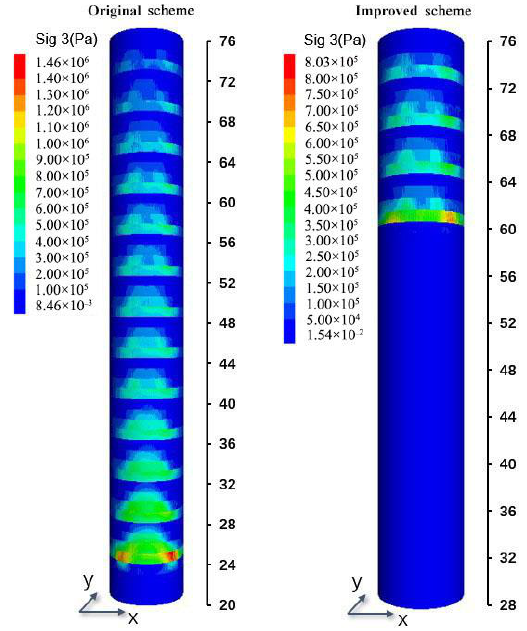
Figure 18. Minor principal stress on the lining.